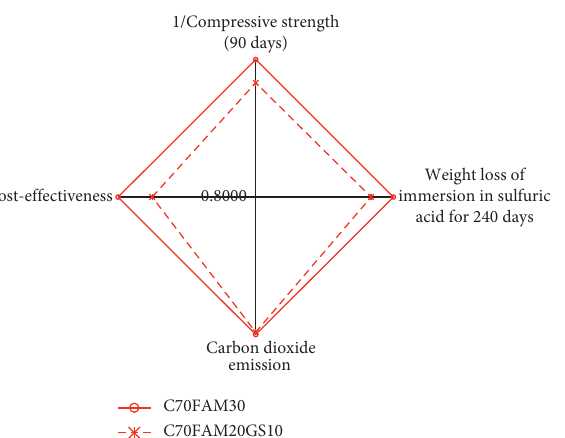
Figure 8: Relative performances of the ternary binder mixture with sand powder (C70FAM20GS10), compared to the binary binder mixture with FAM